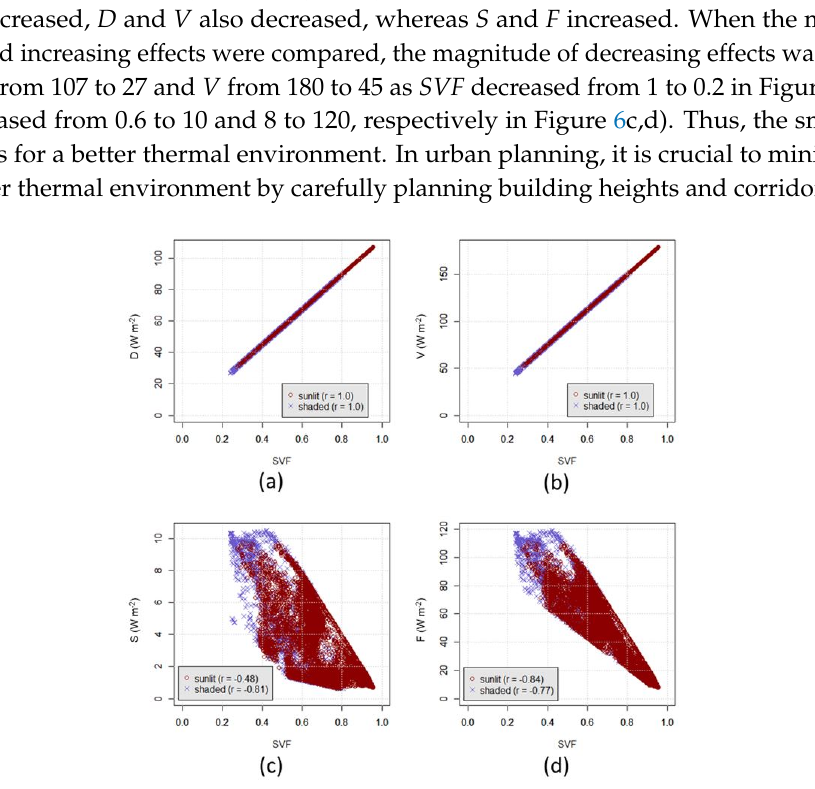
Figure 6. R abs ’s component ( a ) D ; ( b ) V ; ( c ) S ; and ( d ) F as a function of SVF and shade on 9 August 2016 at 1